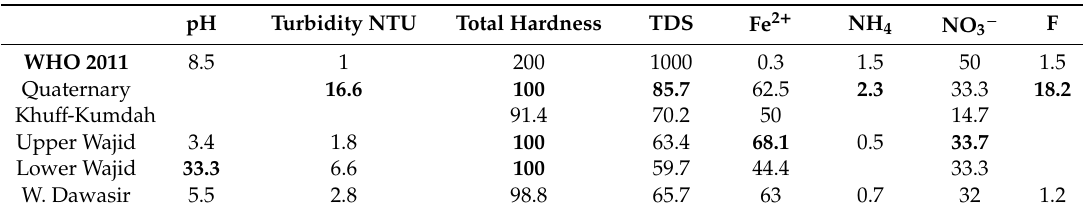
Table 3. Percentage of exceedance of WHO (2011)